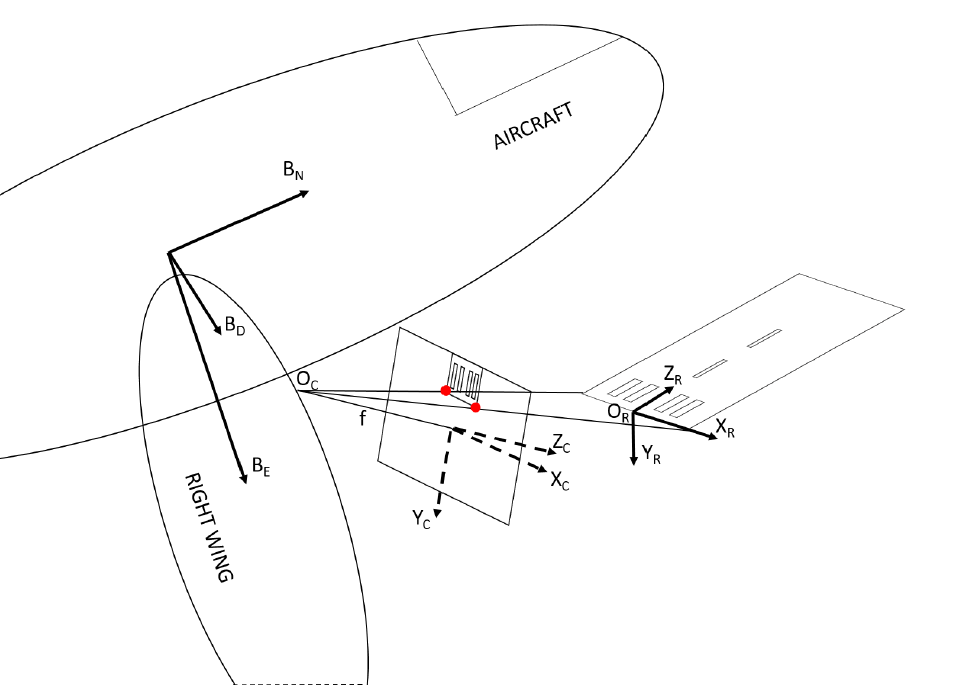
Figure 1. Relevant coordinate systems of vision-based navigation sensor. The origin of runway coordinate system R XYZ is known in GPS LLA system with the 3D heading angle of the runway. The transformation between R XYZ and camera coordinate system C XYZ is the question, while transfor- mation between aircraft body system B NED and the camera C XYZ is determined by